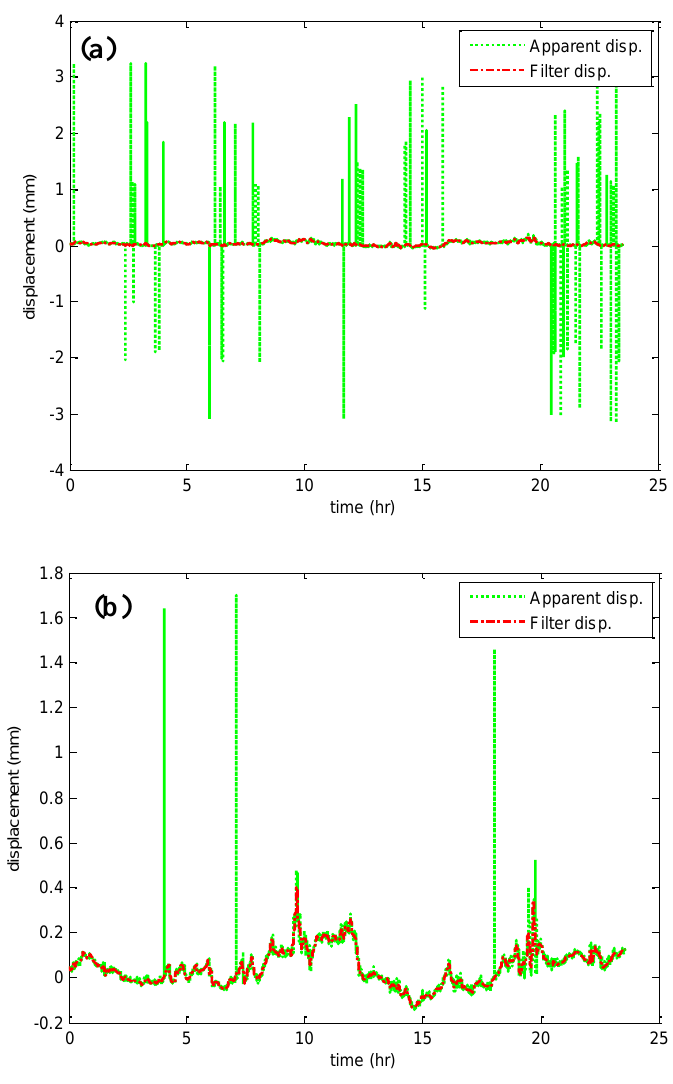
Figure 3. WT de-noising of GPS measurements of ( a ) Points 1 (Deck Point) and ( b ) T1 (Tower Point) in Y